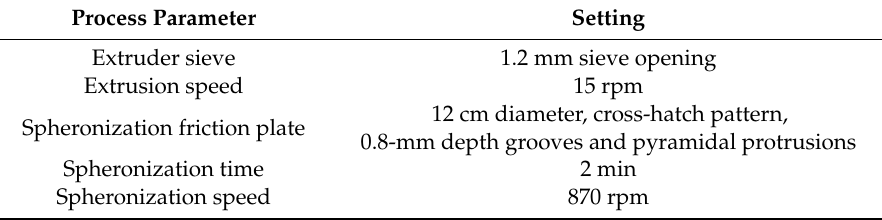
Table 1. The process parameters used in the manufacturing of the inert